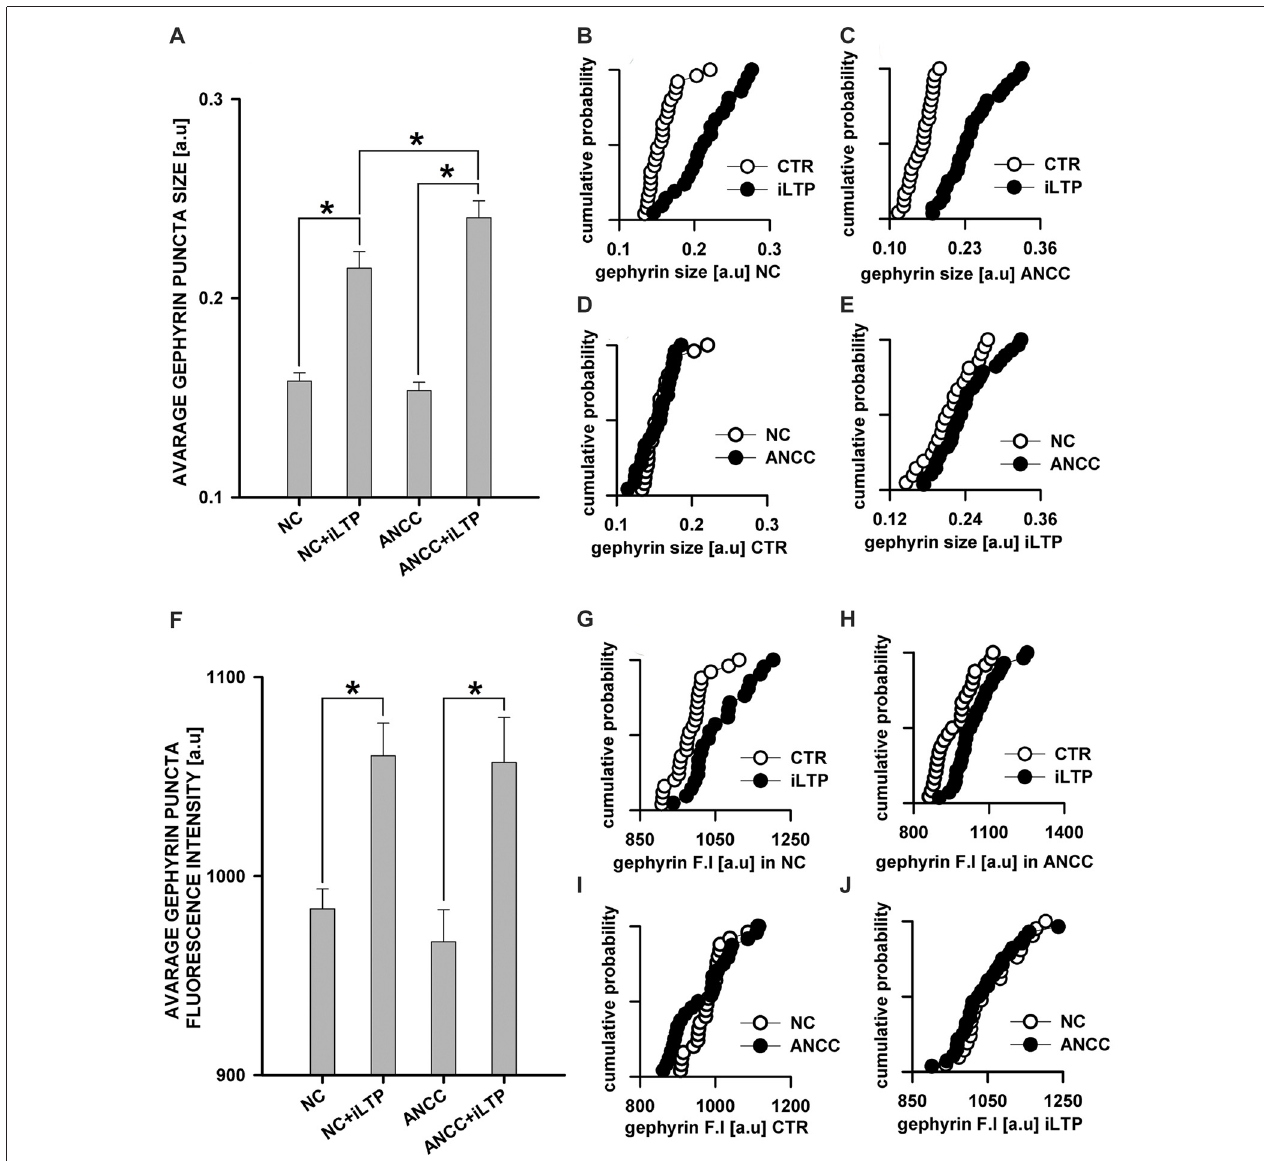
FIGURE 3 | Supplementation of NC with astrocytes strongly upregulate morphological changes introduced by iLTP. (A) Comparison of average gephyrin puncta size in NC and ANCC with or without iLTP induction. Cumulative representation of gephyrin size in (B) NC with and without iLTP induction, (C) ANCC with and without iLTP induction, (D) NC and ANCC without stimulation, (E) NC and ANCC with iLTP induction. (F) Comparison of average gephyrin puncta fluorescence intensity in NC and ANCC with or without iLTP induction. Cumulative representation of gephyrin fluorescence intensity in (G) NC with and without iLTP induction, (H) ANCC with and without iLTP induction, (I) NC and ANCC without stimulation, (J) NC and ANCC with stimulation. Statistical significant results in bar charts ( p < 0.05) are represented with star